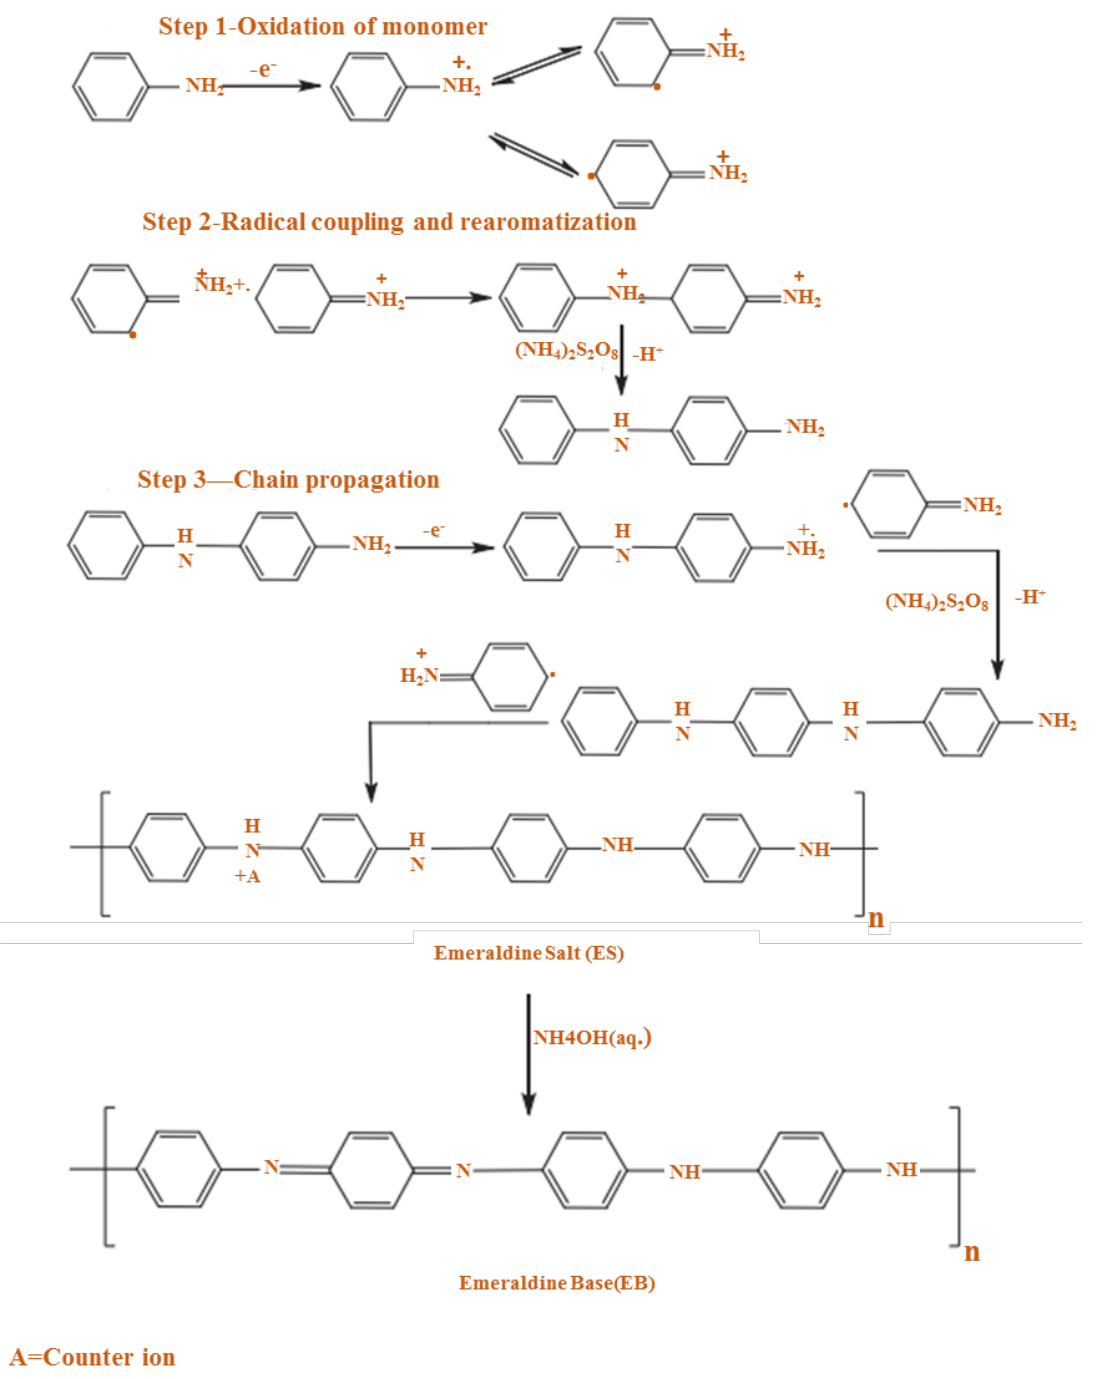
Figure 14. PANI with oxidative polymerization of aniline. Reproduced from Prog. Polym. Sci., Vol 23, Gospodinova, N.; Terlemezyan, L., Conducting polymers prepared by oxidative polymerization: Polyaniline, pp. 1443–1484, Copyright (1998), with permission from Elsevier.